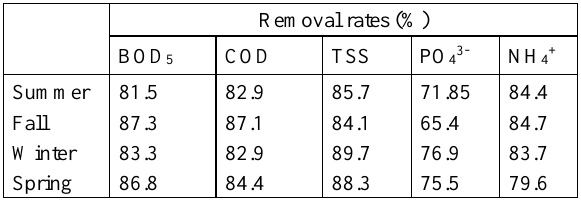
Table 5. Efficiency of V-MSL to remove the